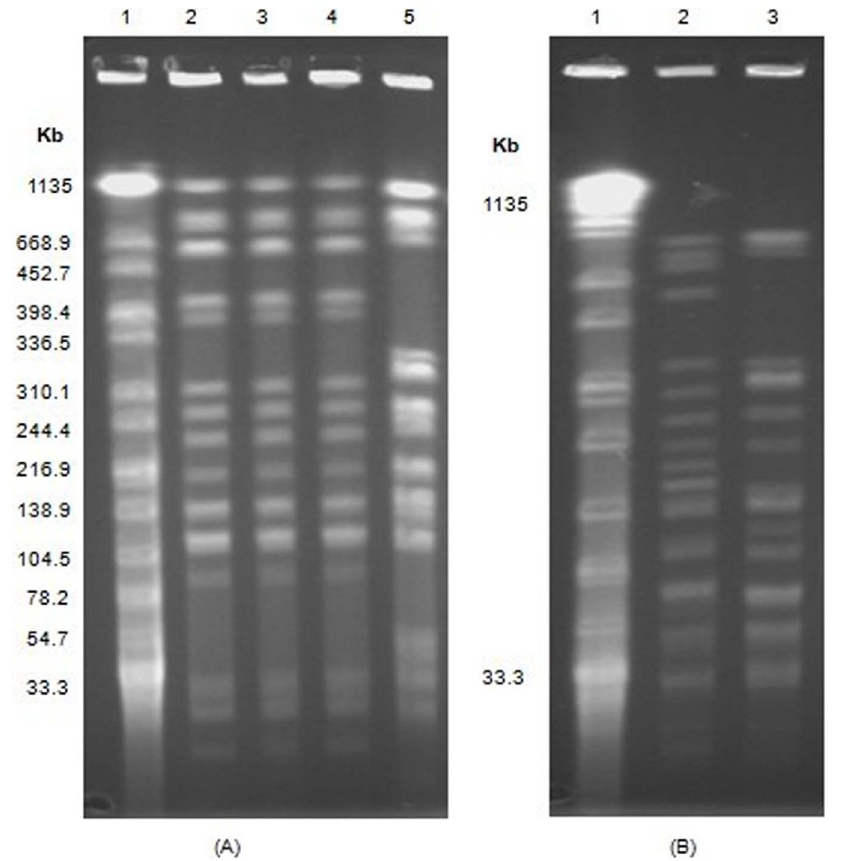
Figure 1. PFGE profiles of Salmonella serotype Braenderup strain (H9812), and four K. pneumoniae and two A. calcoaceticus isolates. (A) PFGE profiles of H9812 and four K. pneumoniae isolates. Lane 1: Salmonella serotype Braenderup strain (H9812), as the marker. Lane 2 , 5: four K. pneumoniae isolates (M186, M187, M194, U091, respectively). (B) PFGE profiles of H9812 and two A. calcoaceticus isolates.